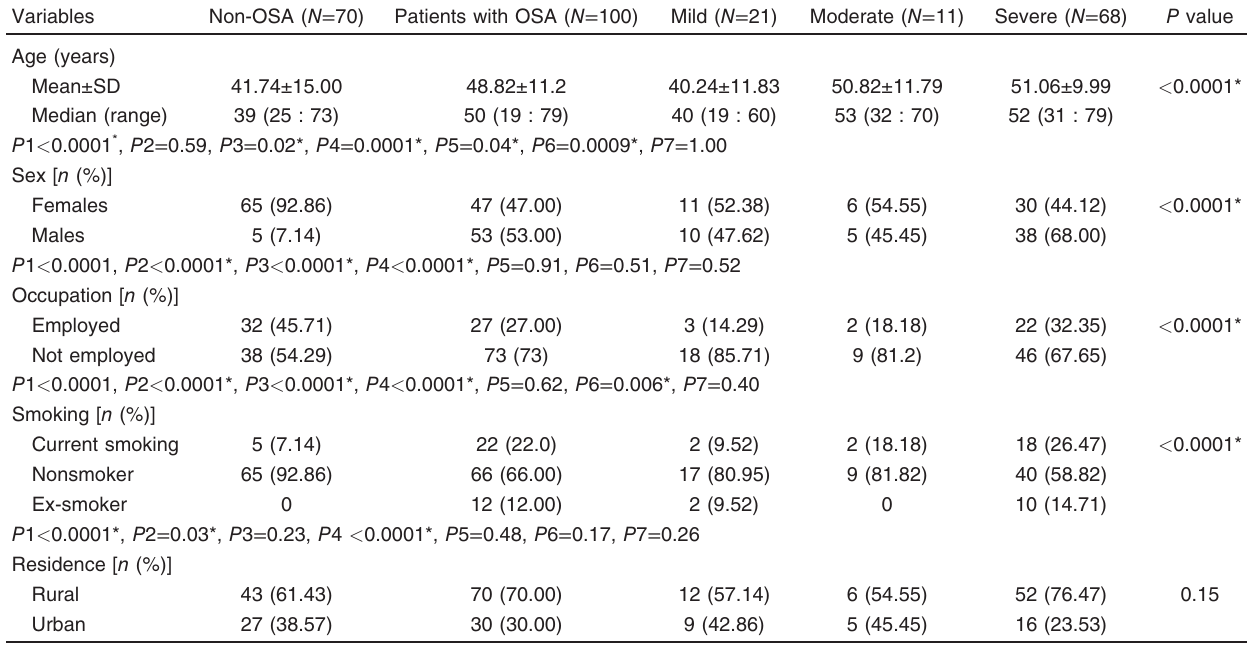
Table 1 Sociodemographic characteristic of studied population in relation to obstructive sleep apnea and its severity Variables Non-OSA ( N = 70) Patients with OSA ( N = 100)